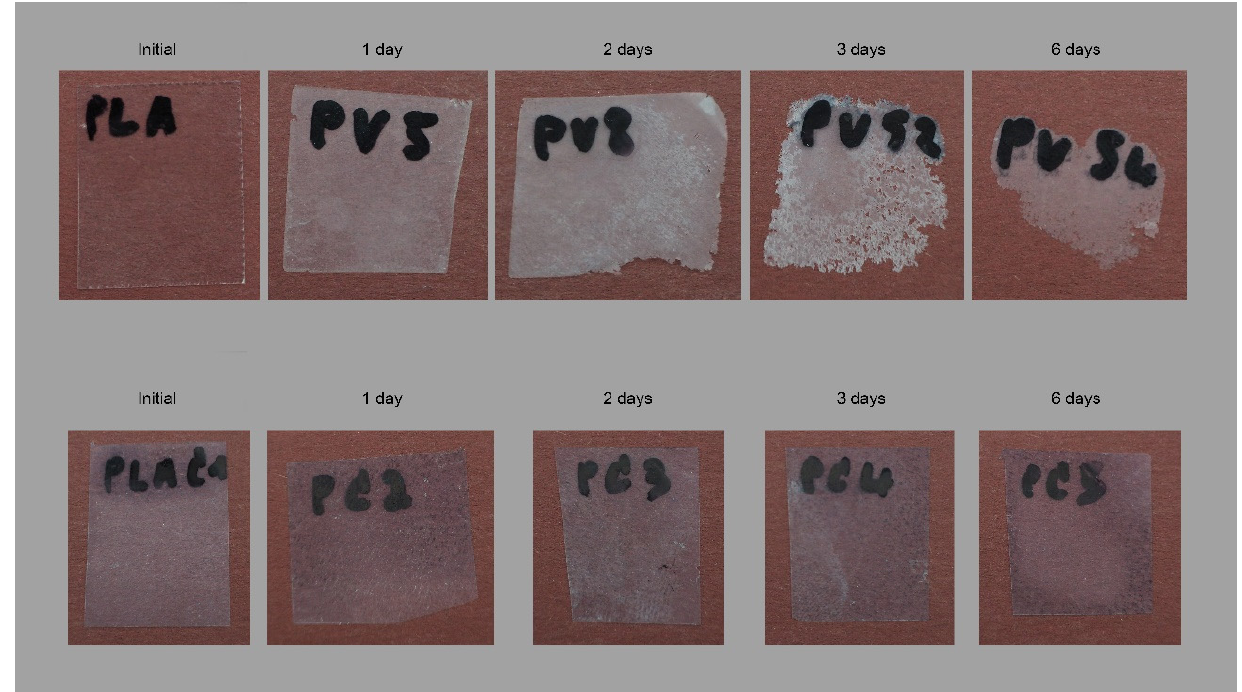
Figure 2. Optical analysis of the biodegradation test in amorphous PLA ( up ) and PLA crystallized ( down ).